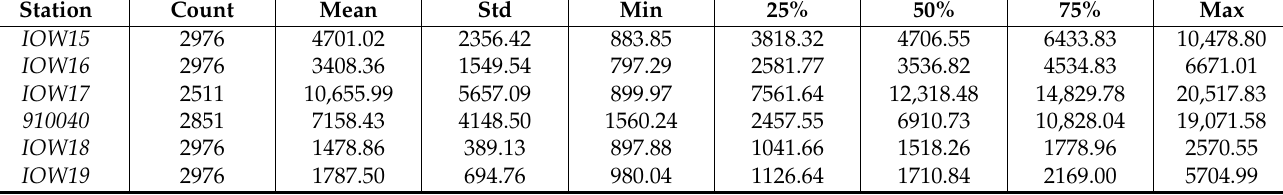
Figure 14. Variable ec : boxplot per station. Table 2. EC25 variable: data description per station (values in